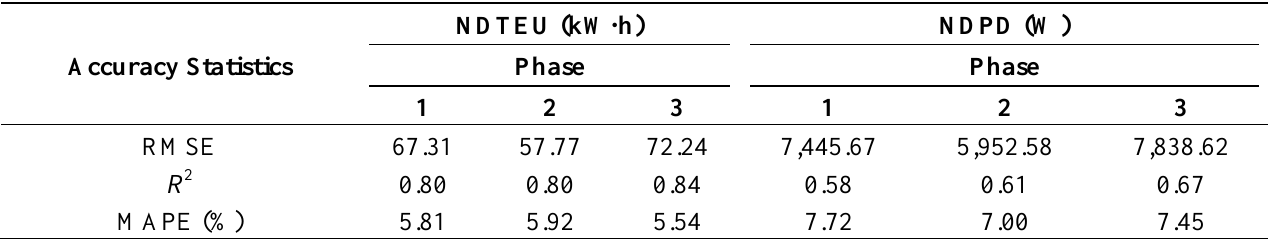
Table 5. NN validation